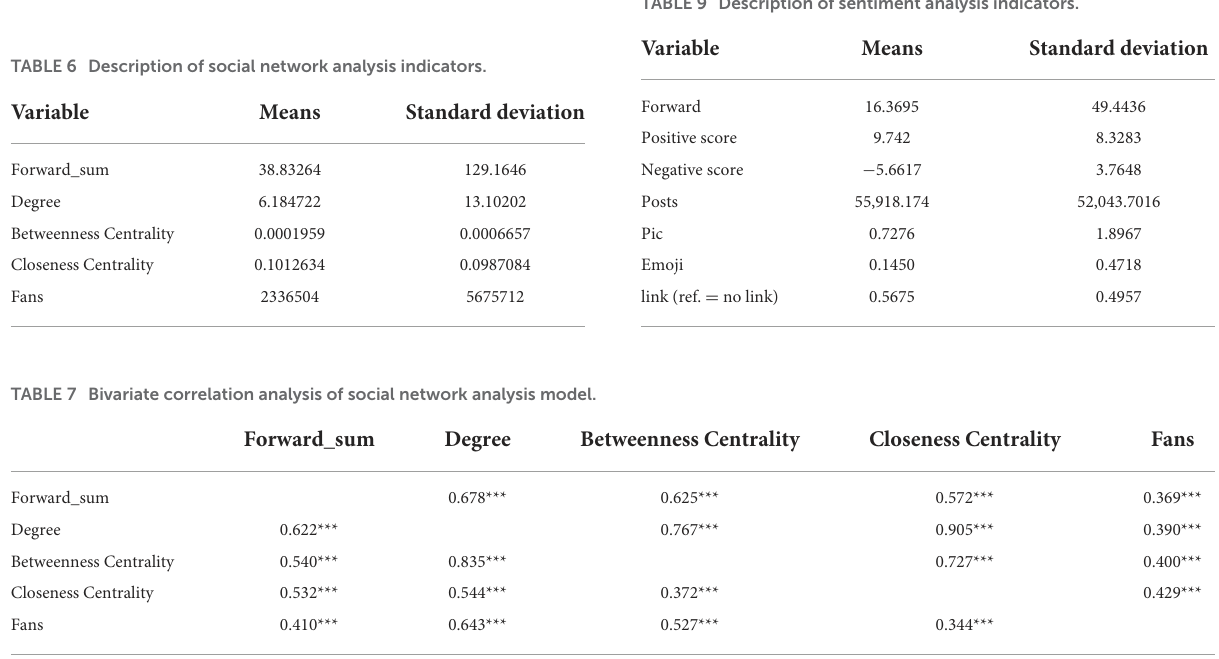
TABLE 9 Description of sentiment analysis indicators.